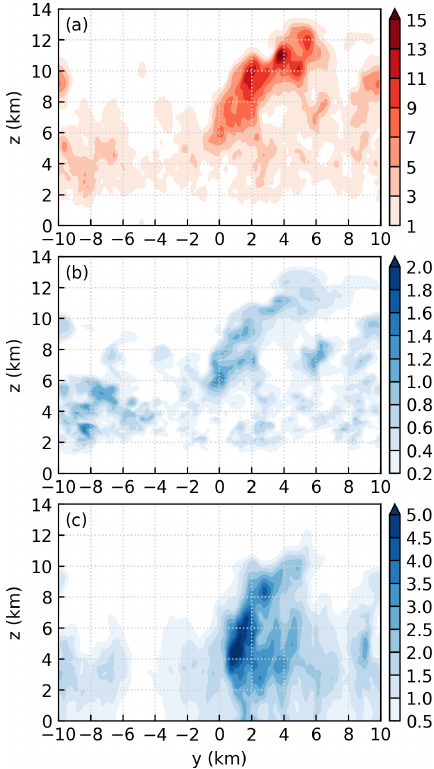
Figure 16. The same as Fig. 10 except at t = 8h